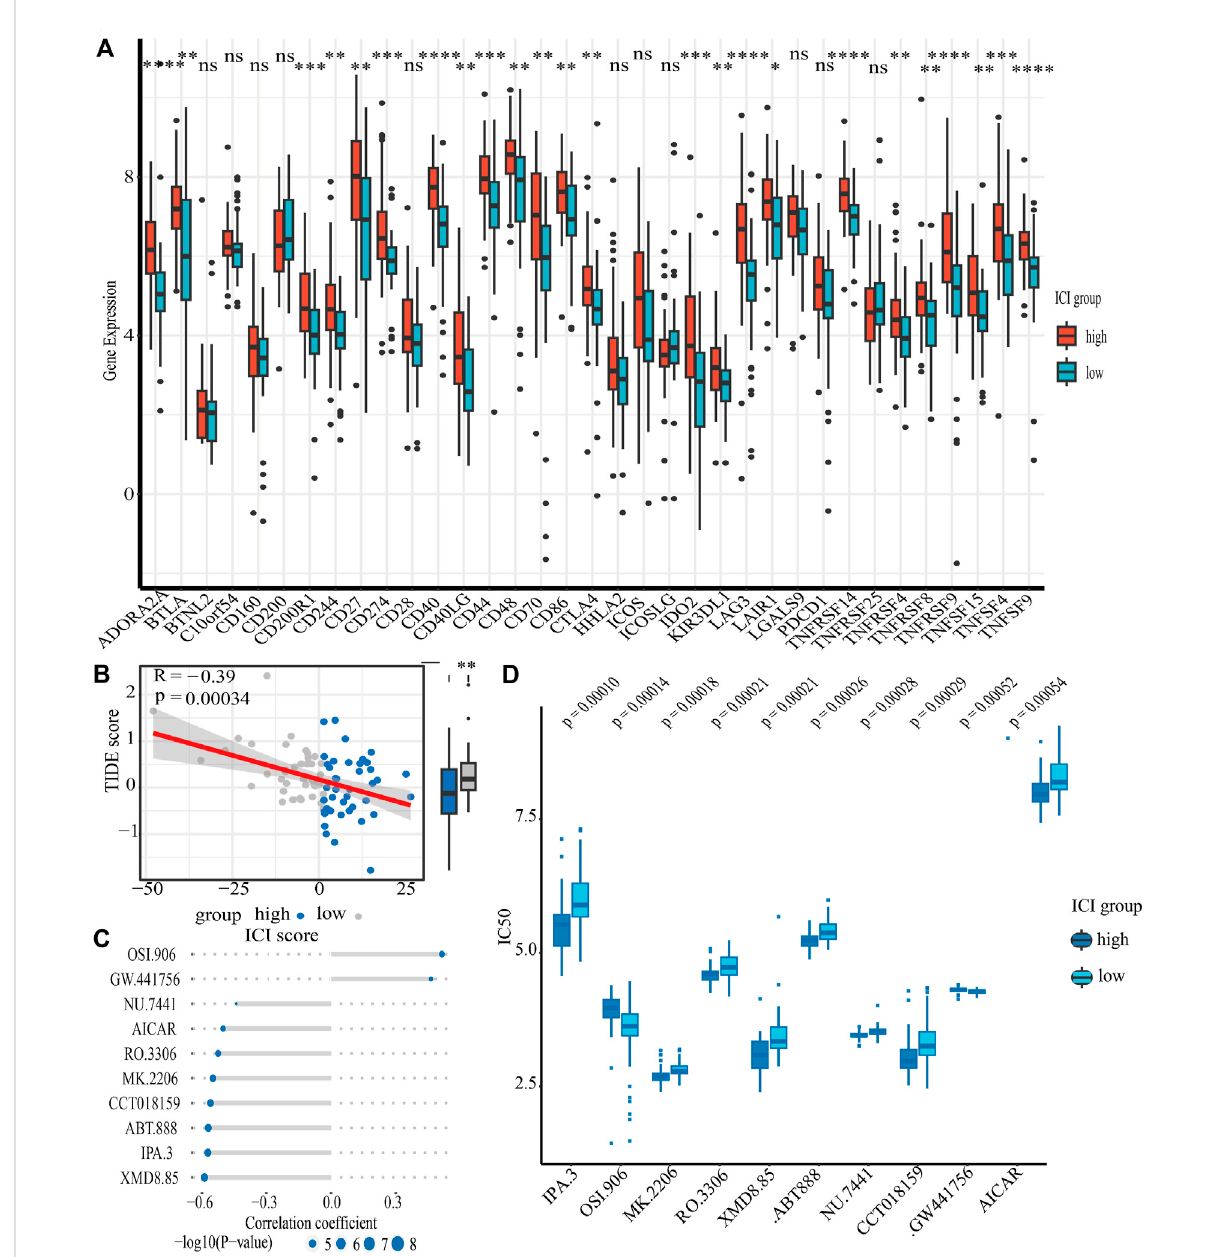
FIGURE 6 TherelationshipbetweenICIscoresanddrugtherapy. (A) Theresultsofdifferentialexpressionofimmune checkpointgenesinhighandlowICI score groups. (B) The results of spearman ’ s correlation analysis of ICI scores with TIDE scores (TIDE scores serve as a well-recognized indicator of immunotherapticresponse). (C) Theresultsofspearman ’ scorrelationanalysisofICIscoreswithtentargeteddrugs. (D) Theresultsofdifferentialdrug response analysis of ten targeted drugs in high and low ICI score groups (Lower values on the y -axis of boxplots imply greater drug